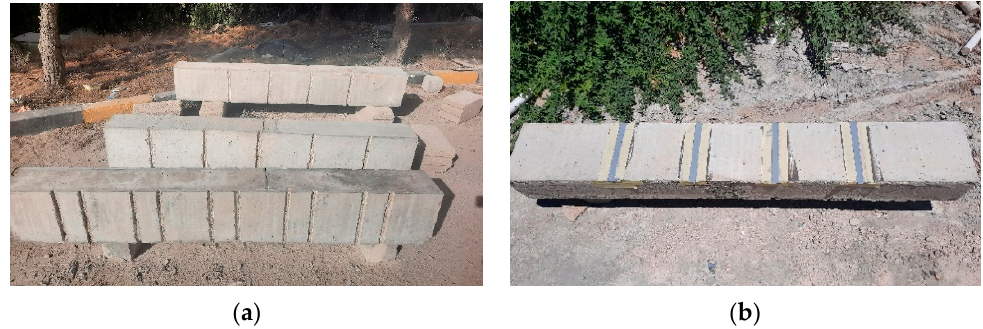
Figure 4. NSM ‐ CFRP installation: ( a ) preparation of groove and ( b ) NSM ‐ CFRP installation.